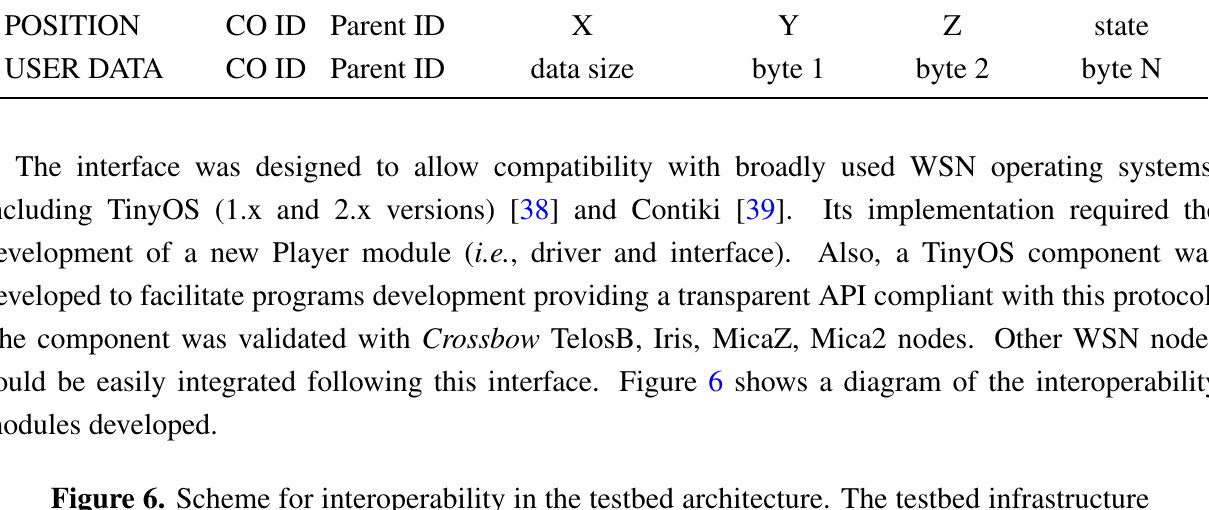
Figure 6. Scheme for interoperability in the testbed architecture. The testbed infrastructure (blue) abstracts hardware and interoperability specificities. The testbed user can provide code to be executed in the WSN nodes (green square) and the robots (orange square) in a variety of programming languages or use any of the basic functionalities